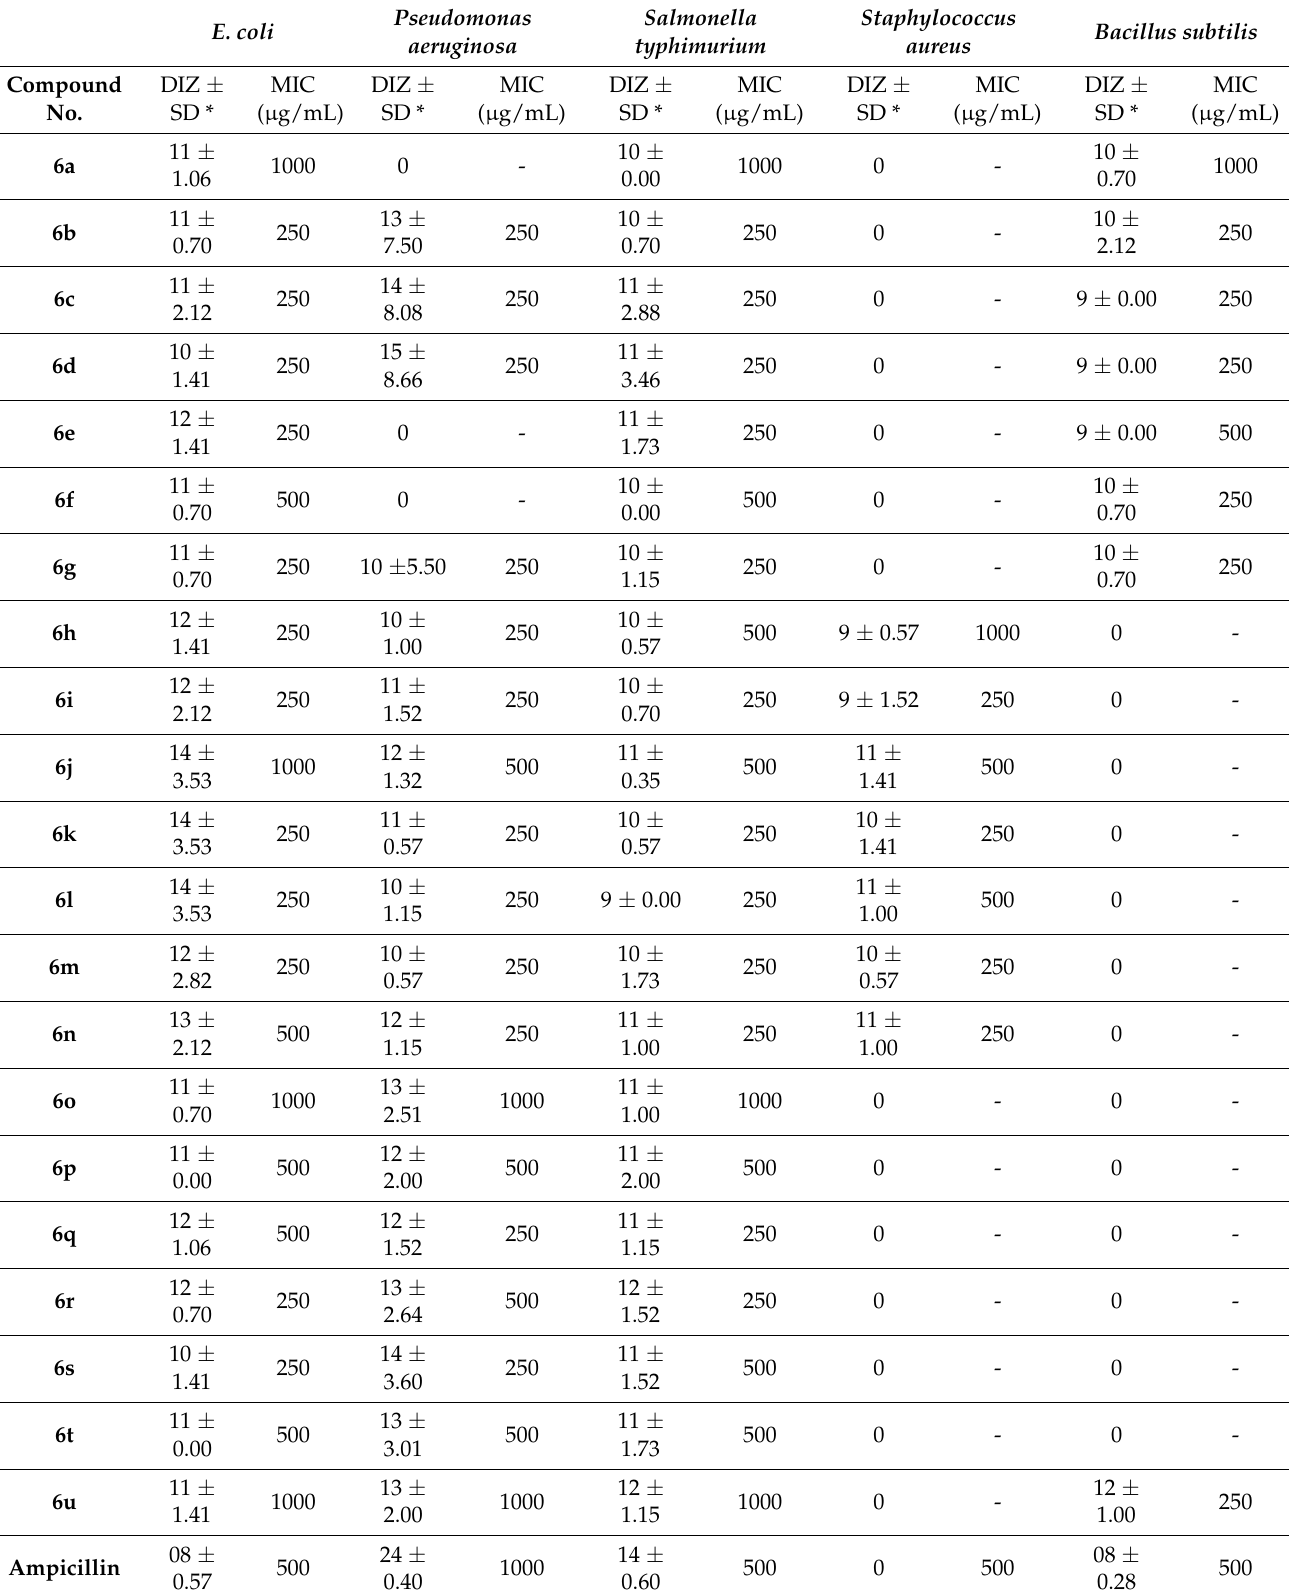
Table 1. Antibacterial activity of the target compounds 6a-u against E. coli, Pseudomonas aeruginosa, Salmonella ty- phimurium, Staphylococcus aureus, and Bacillus subtilis. E. coli Compound